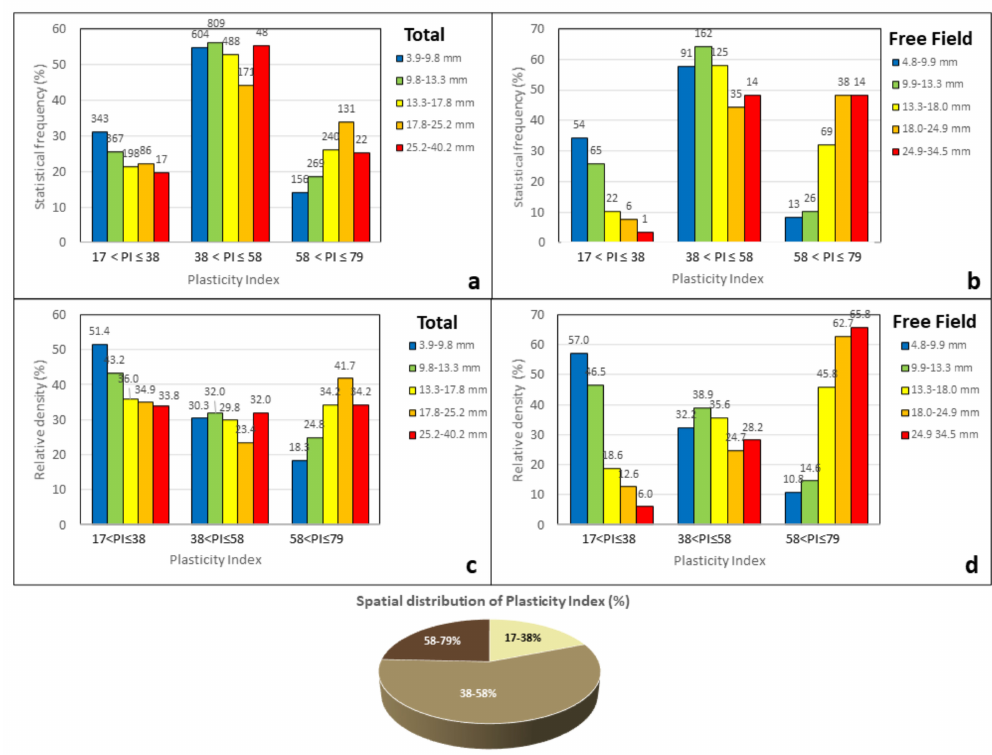
Figure 11. Statistical frequency ( a , b ) and relative density ( c , d ) of the vertical displacement amplitude points as a function of the khaki marl Plasticity Index for total and free field PS points.